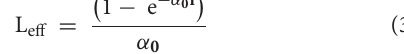
between the peak and valley, the magnitude of the phase shift 1ϕ 0 is given | |